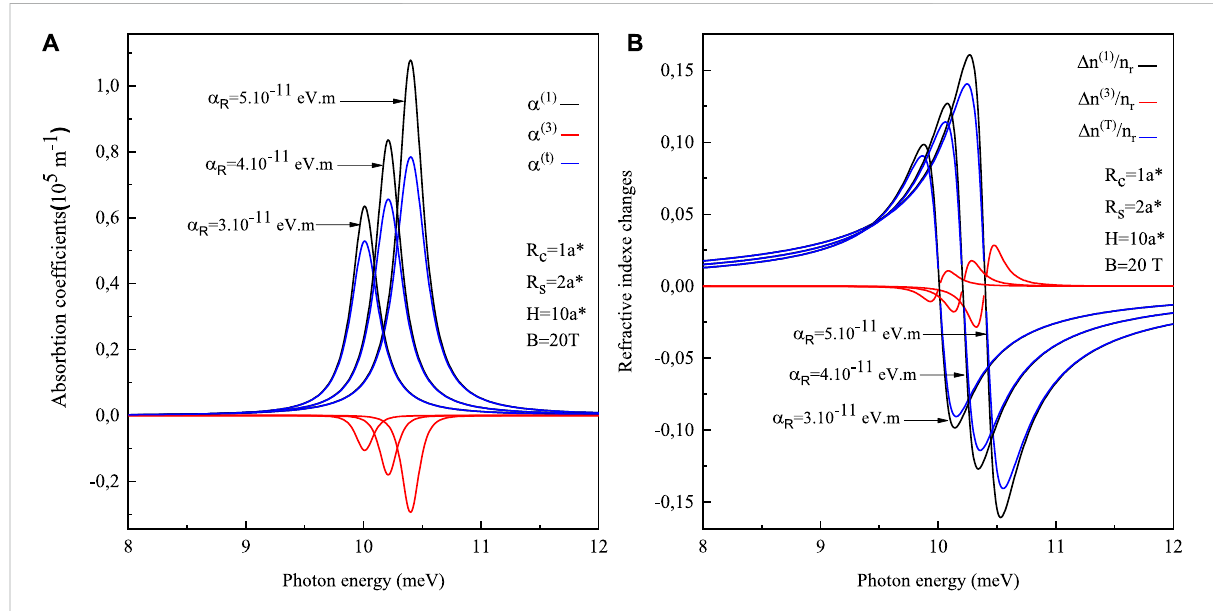
FIGURE 6 Thelinear,thethirdordernonlinearandthetotalabsorptioncoef fi cients (A) andtherefractiveindexchanges (B) asfunctionsofincidentphoton energy with different RSOI strengths. Here the parameters of CCSQD are as: R c = 1 a *, R s = 2 a *, H = 10 a *.